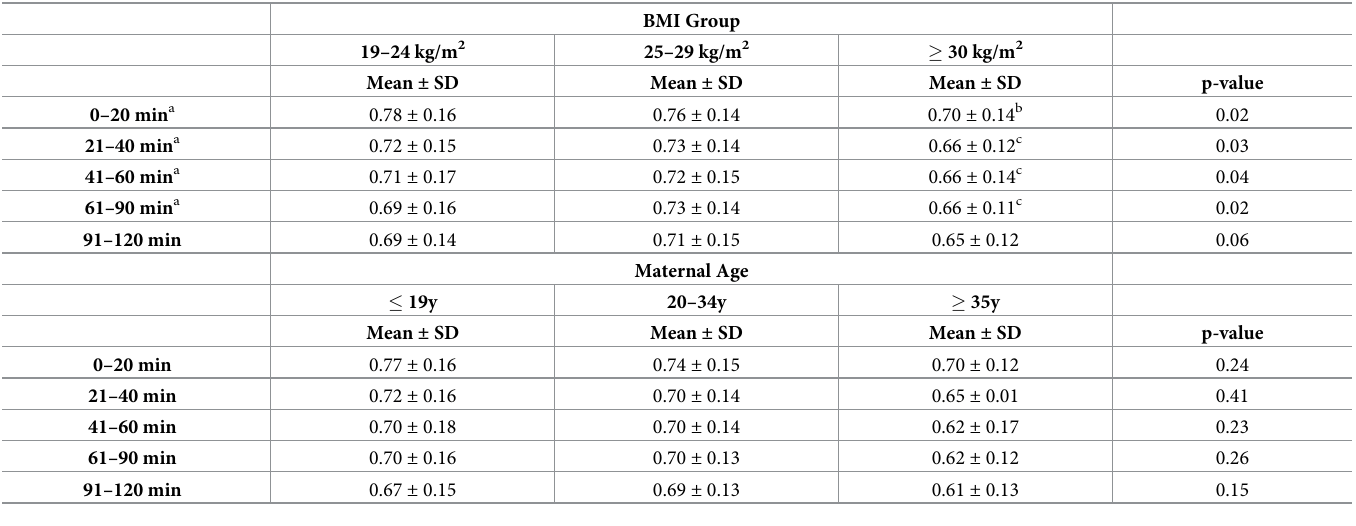
Table 3. Mean and standard deviation of SI by BMI group and maternal